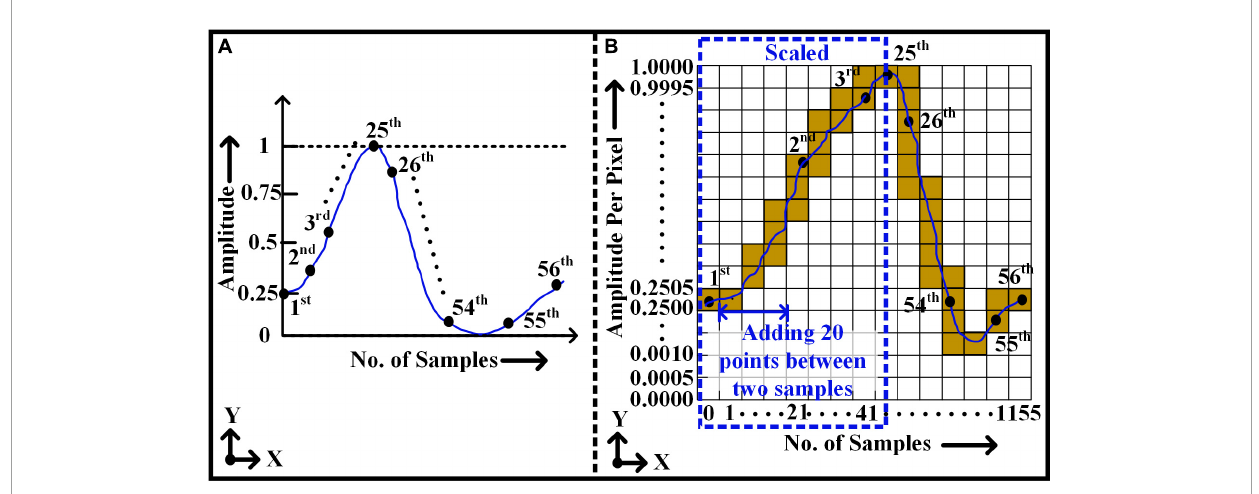
FIGURE3 Rasterization approach - converting 1D vector of non-stationary signal to 2D pixel image. (A) 1D window frame – 1 × 56 size. (B) 2D window frame after rasterization - 2001 × 1155 size.